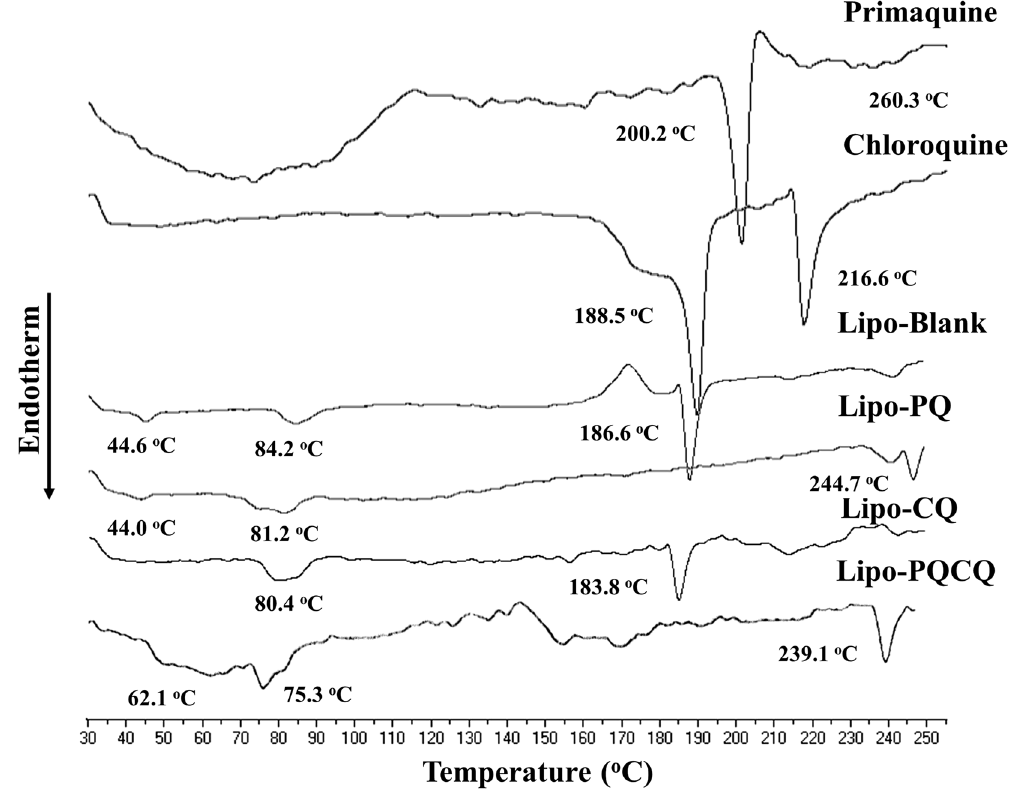
Figure 4. Differential thermal analysis of blank liposomes (Lipo-Blank), primaquine-loaded liposomes (Lipo-PQ), chloroquine-loaded liposomes (Lipo-CQ), and liposomes loaded with both primaquine and chloroquine